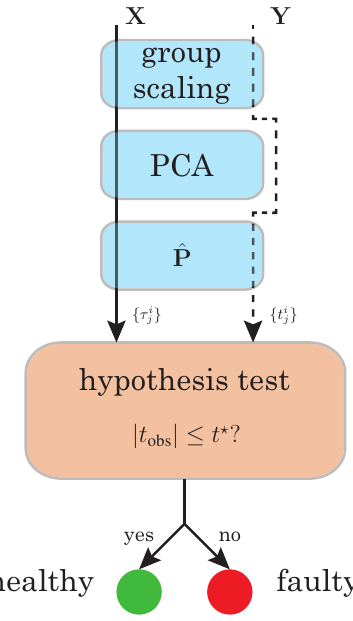
Figure1. Damagedetectionwillbebasedontestingforsignificantchangesinthedistributionsofsamples T h and T c . Figure 6. Fault detection will be based on testing for significant changes in the distributions of the baseline sample and the sample coming from the wind turbine to